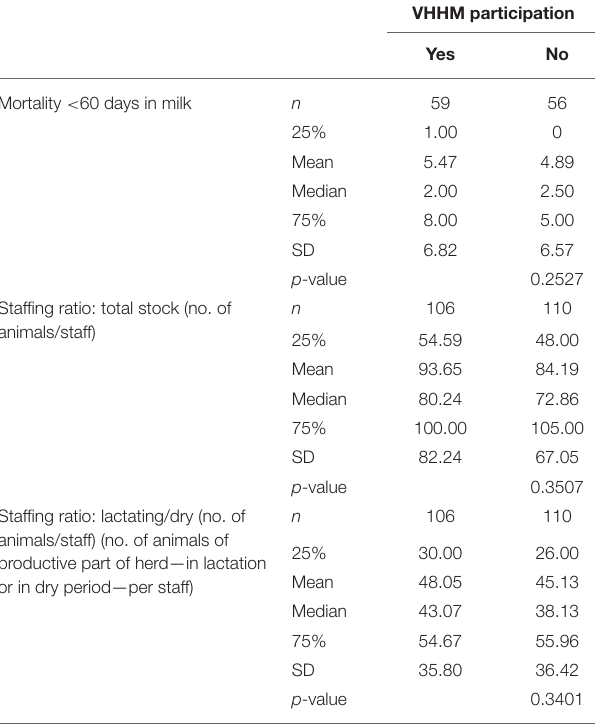
Staffing ratio: lactating/dry (no. of animals/staff) (no. of animals of productive part of herd—in lactation or in dry period—per